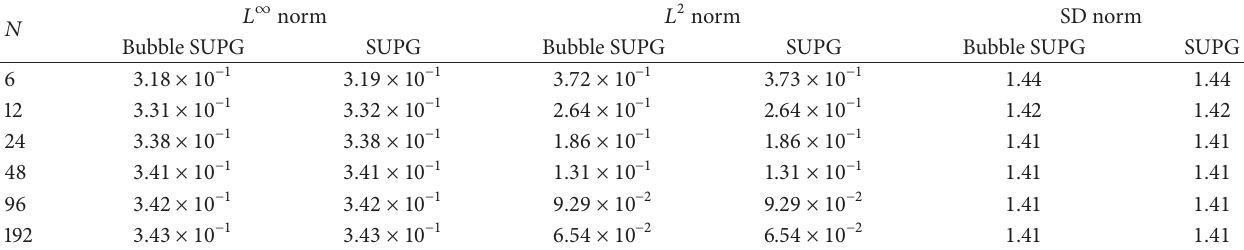
Table 17: 𝜀 = 10 −8 , Problem 1 (comparison of global error).